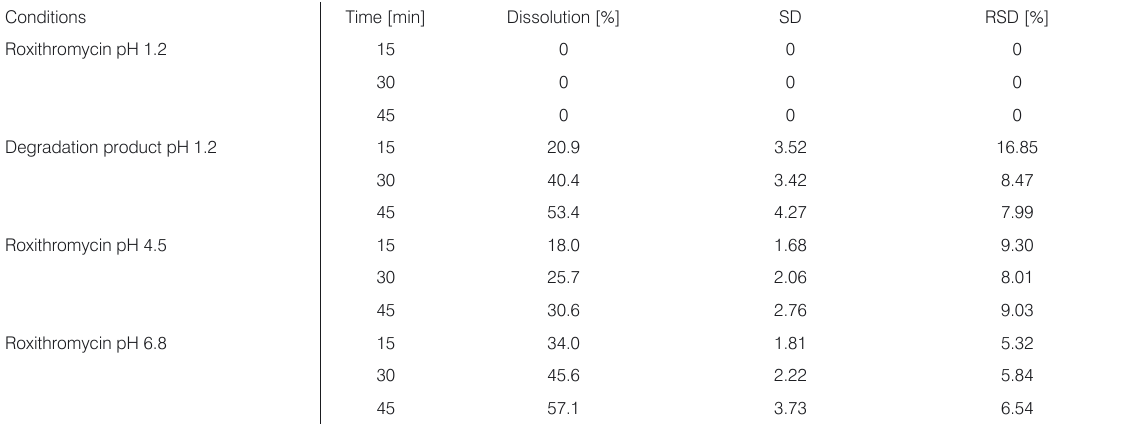
Figure 3. Dissolution of roxithromycin and its degradation product from tablets for oral suspension at pH 1.2, 4.5, and 6.8.